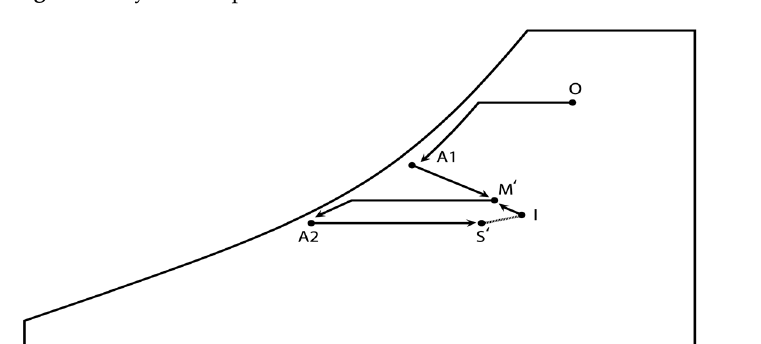
Figure 1. Layout for option A.